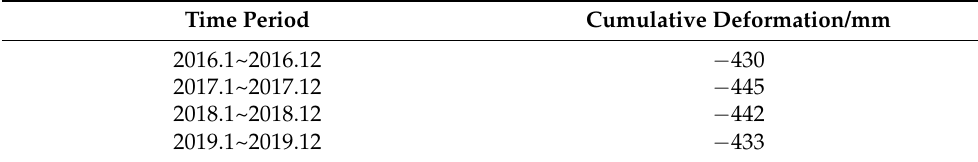
Figure 6. ( a ) Deformation rate map in the direction of LOS of the Guobu slope; ( b ) cumulative deformation map of the Guobu slope at some moments. Table 2. The annual cumulative deformation during the monitoring